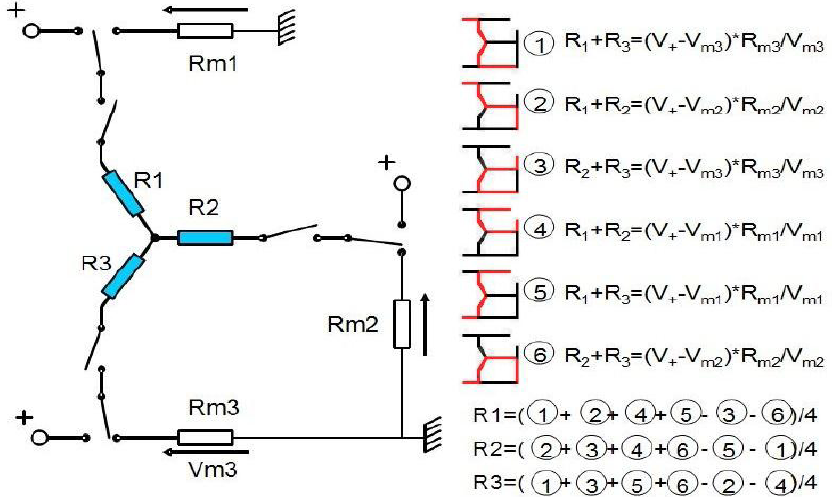
Figure 3. Principle of alternated resistance measure. The six circuits represented